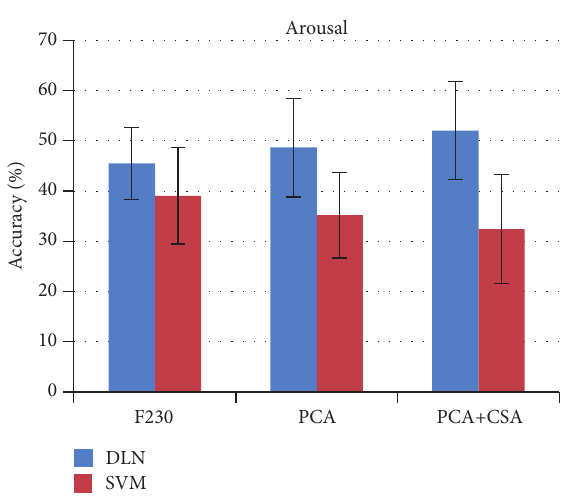
Figure 15: DLN versus SVM arousal accuracy.